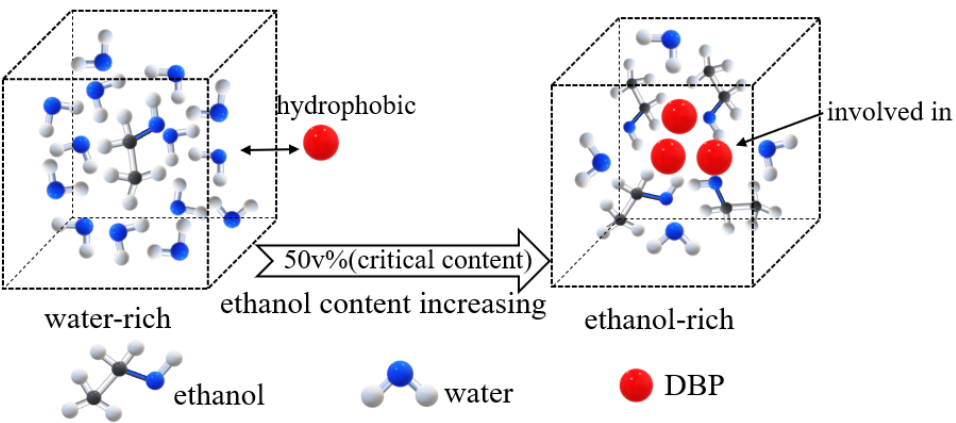
Figure 4. Mechanism diagram of DBP and water–ethanol clusters.